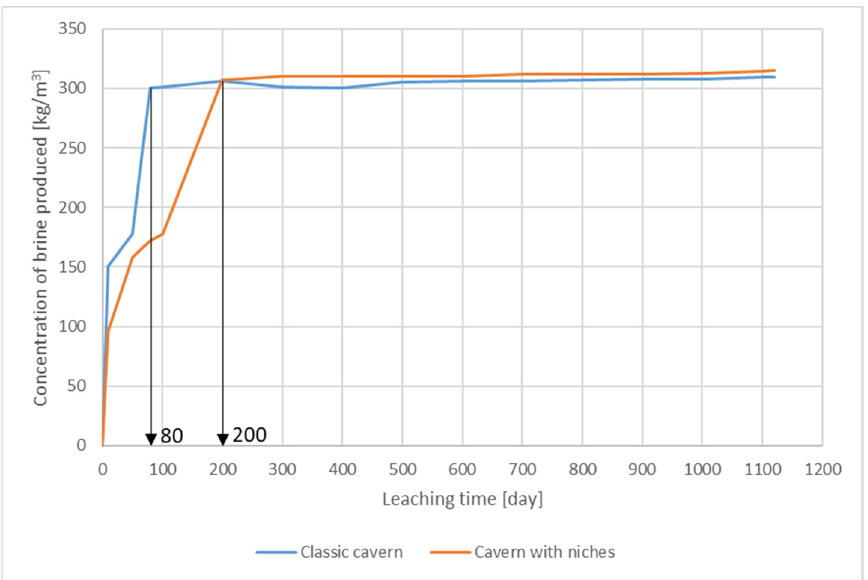
Figure 21. Comparison of the brine concentration of the obtained brine for the cavern made classically and with the use of niches.